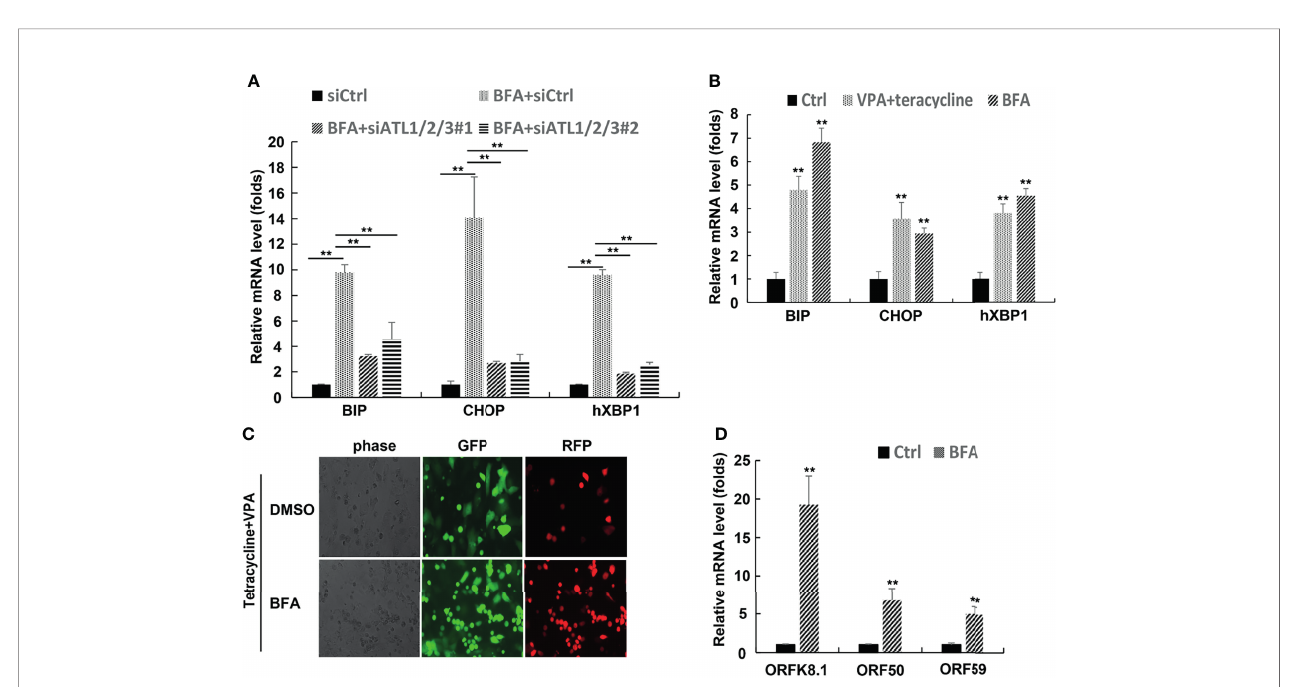
FIGURE 9 | Silencing of ATLs impairs the response of cells to endoplasmic reticulum (ER) stress, and ER stress can promote the lytic reactivation of KSHV. (A) iSLK.rKSHV.219 cells were transfected with siCtrl, siATL1/2/3#1 or siATL1/2/3#1 respectively followed by treated with BFA for 24 hours. mRNA levels of ER stress related genes BIP, CHOP and hXBP1(s) were measured by RT-qPCR, with normalization to actin using the DD CT method. (B) iSLK.rKSHV.219 cells were treated with tetracycline plus VPA or BFA for 24 hours, mRNA levels of ER stress related genes BIP, CHOP and hXBP1(s) were measured by RT-qPCR, with normalization to actin using the DD CT method. iSLK.rKSHV.219 cells were treated with DMSO or BFA for 1 hours followed by treatment with tetracycline plus VPA for 48 hours to induce KSHV lytic reactivation. The cells were photographed for GFP and RFP fl uorescence (C) . mRNA levels of KSHV lytic genes ORFK8.1, ORF50 and ORF59 were measured by RT-qPCR (C) . Data are presented as means of three technical replicates (n=3, group values are indicated by mean ± SEM; ** p <